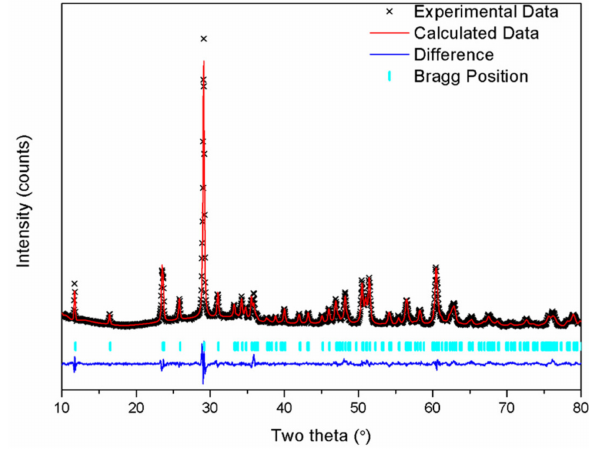
Figure 2. Powder XRD pattern of a fraction of the crystal. Table 1. Structure information from structure refined results.